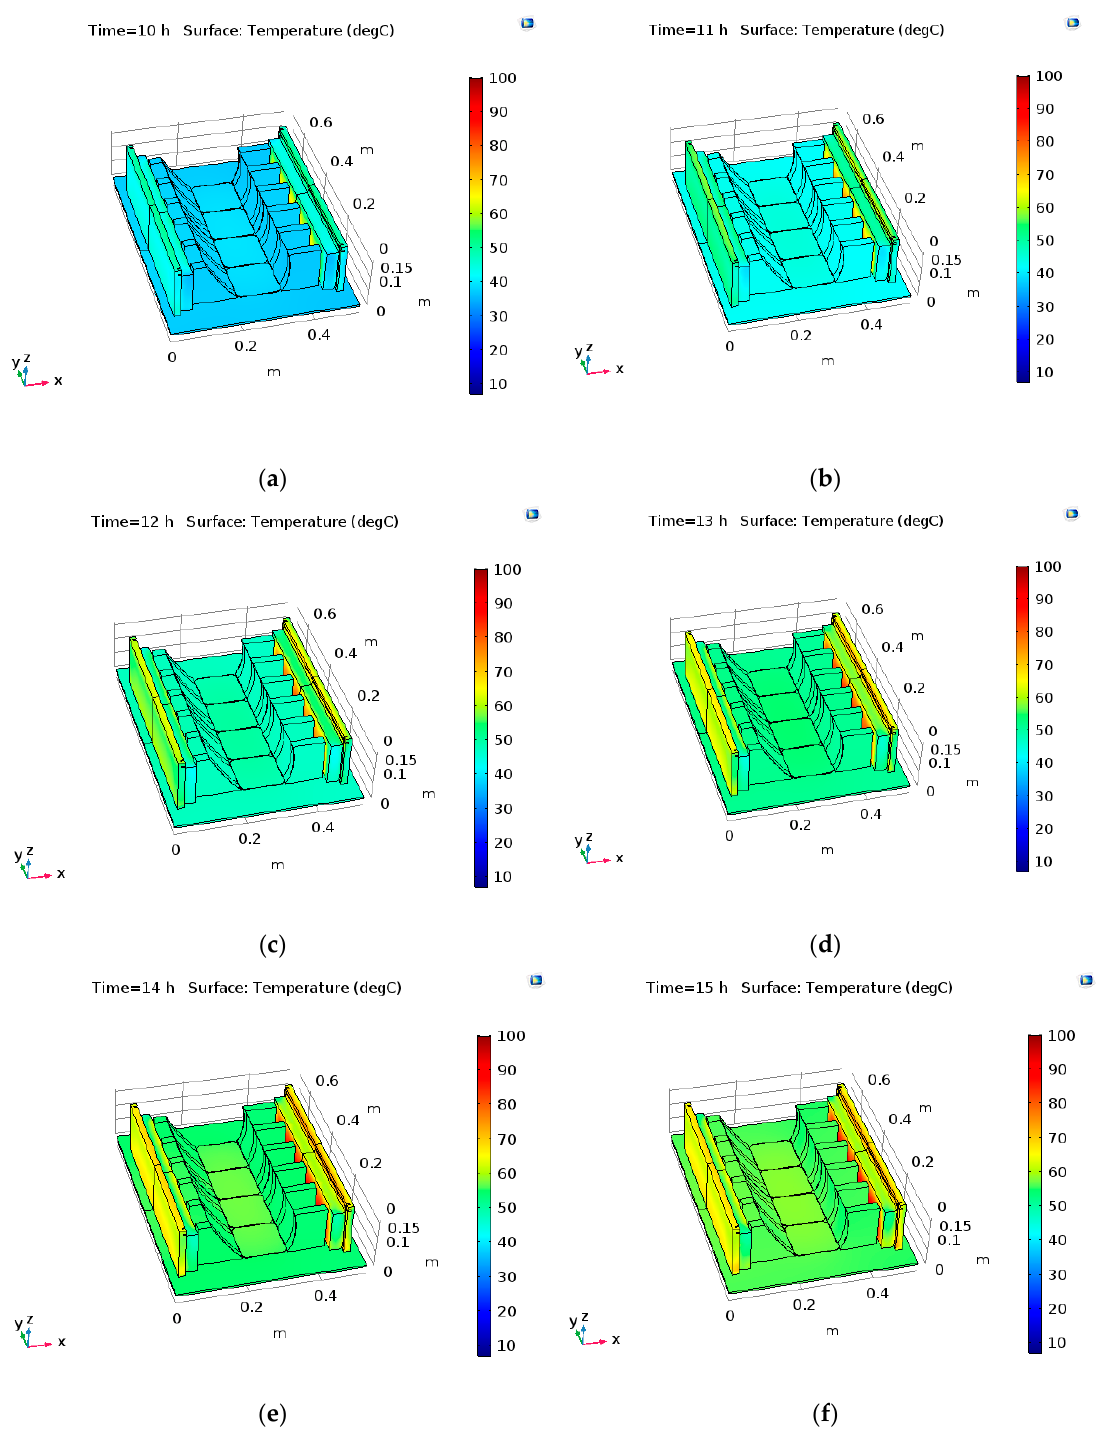
Figure A2. Temperature field on the whole surfaces of the assembly for the uncovered CPC scenario (18 July 2017) at the following times: ( a ) 10:00; ( b ) 11:00; ( c ) 12:00; ( d ) 13:00; ( e ) 14:00; ( f ) 15:00.